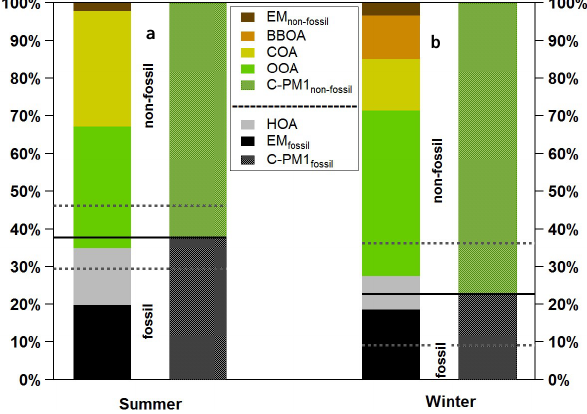
Figure 7. Combined analysis of AMS-derived PM 1 OA fractions and elemental carbon with results from fossil fuel and non-fossil fuel carbon 14 C analysis, for the summer (a) and the winter (b) cam- paign at the urban downtown site. The left columns for each season show the source apportionment from AMS and EC measurements, the right columns show the fossil fuel and non-fossil fuel fractions of carbonaceous PM 1 . Combined, both columns allow the attribu- tion of the individual aerosol types to fossil fuel and non-fossil fuel parts. EM denotes elemental carbon matter, BBOA biomass burning OA, COA cooking OA, OOA oxygenated OA, HOA hydrocarbon- like OA (associated with road transport). The dashed lines represent the combined uncertainties of the 14 C measurement and the splits between OC and EC, fossil fuel and non-fossil fuel EM and OOA and their variability as a fractional contribution to carbonaceous PM 1 . Note that for wintertime, the fossil fuel EC and primary OA fractions identified from AMS-PMF analysis are somewhat larger than the total fossil fuel carbonaceous PM 1 from the 14 C analysis, but agree within their